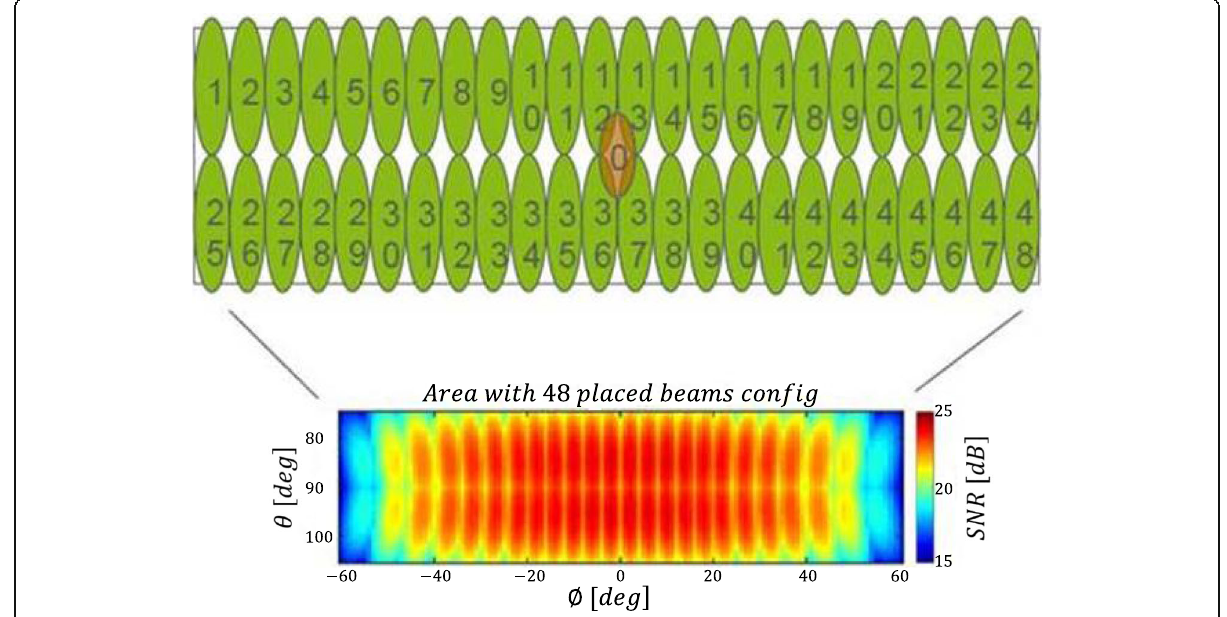
Fig. 3 TX pattern of a commercial 5G antenna: Beam index mapping for TX, 28